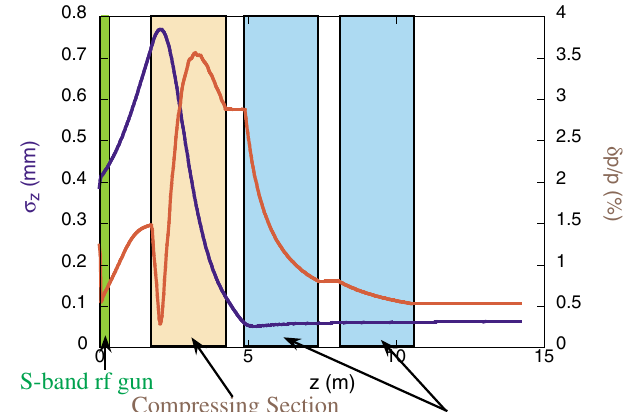
FIG. 20. (Color) HOMDYN simulation of the bunch length and relative energy spread in the velocity-bunching scheme imple- mented at PLEIADES. The bunch charge in this case is 250 pC. The rms bunch length (plotted in blue) initially increases in the drift region between the rf gun and the compressing traveling wave linac section. Unlike the ORION simulations, the majority of the compression occurs within the first linac section and the minimum bunch length, 50 (cid:4) m , is achieved at the entrance to the second linac section. The rms energy spread (plotted in red) follows a pattern similar to the ORION case, peaking at a few percent in the compressor and decreasing in the following two sections to a final value of